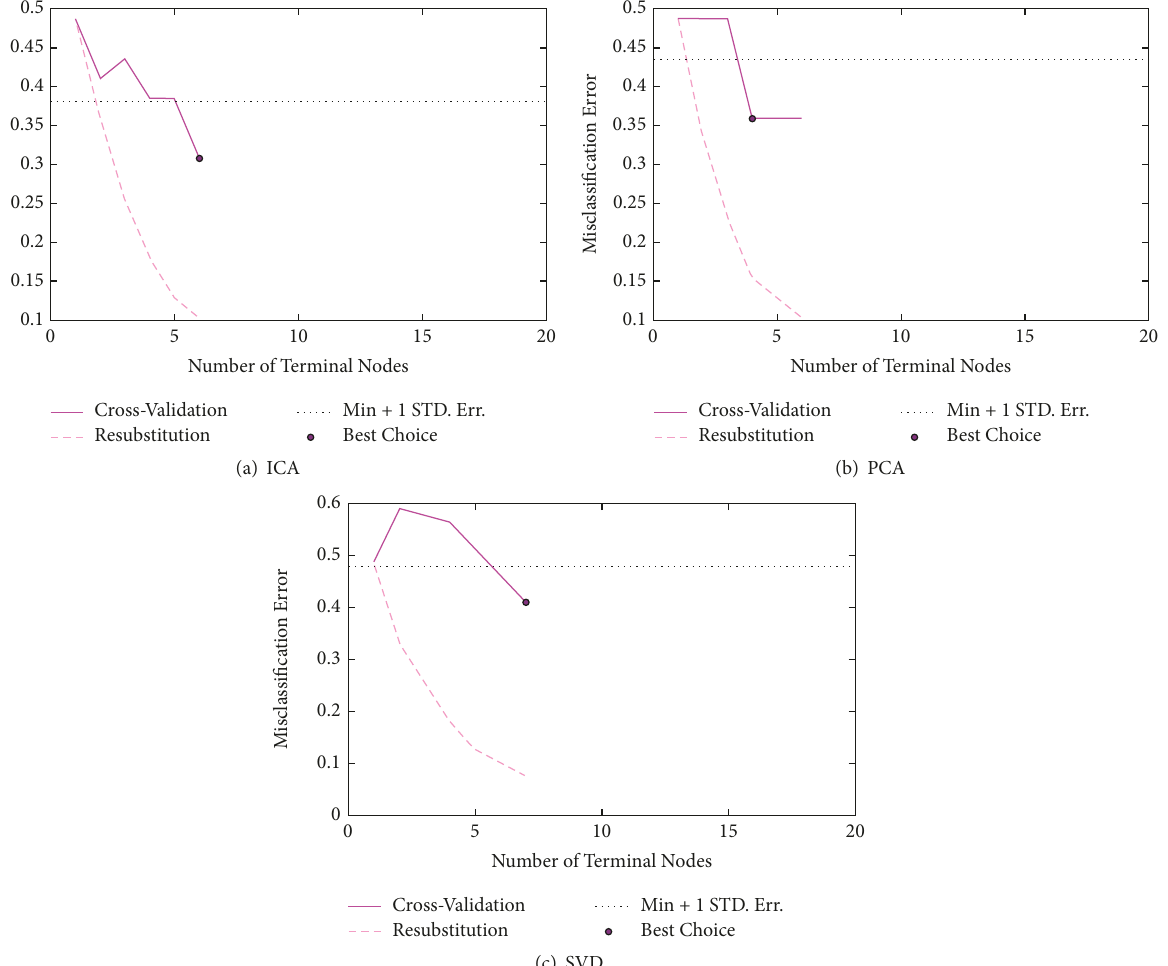
Figure 4: Misclassification error for the CART for different numbers of terminal nodes with ICA, PCA, and SVD data reduction techniques.